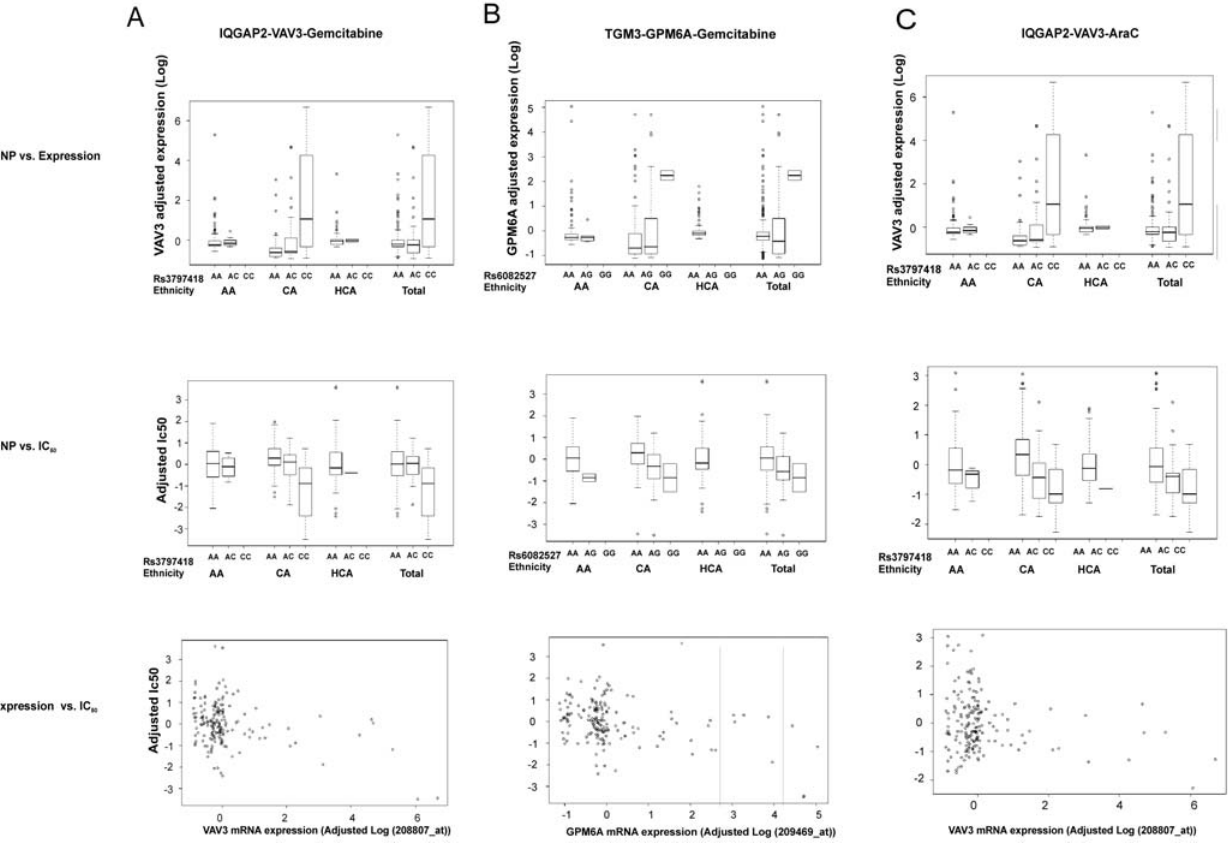
Figure 4. Association among SNPs in IQGAP2 and TGM3 with expression and gemcitabine or AraC cytotoxicity. (A) SNP rs3797418 (A/C) association with VAV3 expression, gemcitabine IC 50 values and VAV3 expression association with gemcitabine IC 50 in individual ethnic groups and all of the cell lines. (B) SNP rs6082527 (A/G) association with GPM6A gene expression, gemcitabine IC 50 values and GPM6A gene expression association with gemcitabine IC 50 values. (C). SNP rs3797418 (A/C) association with VAV3 expression, AraC IC 50 values and VAV3 expression association with AraC IC 50 in individual ethnic groups and all of the cell lines. Each dot represents one sample. Genotypes for each SNP are plotted against gene expression levels (upper panels) as well as gemcitabine or AraC IC 50 values (middle panels). In the lower panel, correlations were determined between gene expression levels and gemcitabine or AraC IC 50 values.